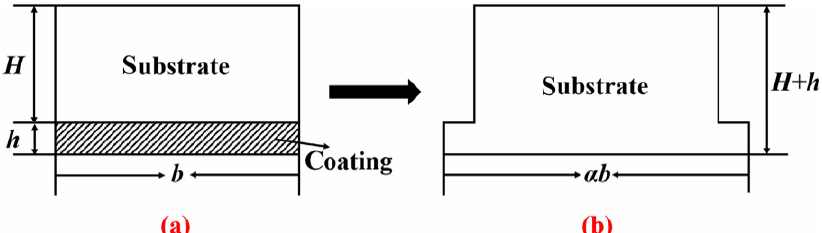
Fig. 3 Schematics of the cross-section transformations of a single-face coated sample: (a) heterogeneous cross-section, (b) homogeneous section.